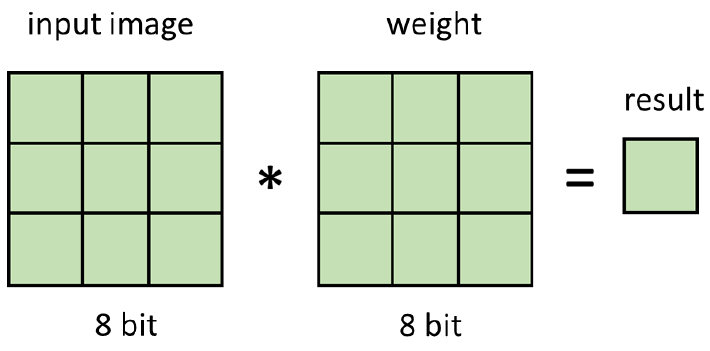
Figure 14. Convolution